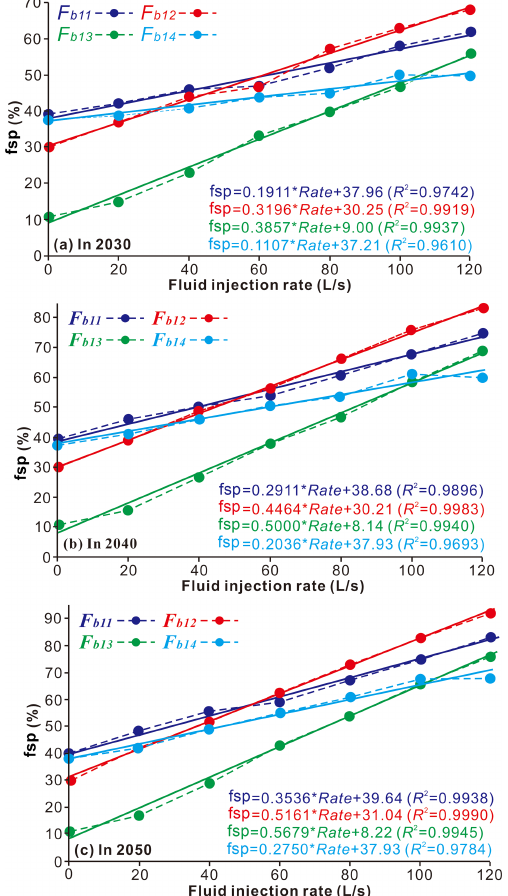
Figure 13. The effect of the injection rate on probabilistic fault slip potential on the mapped faults F b11 , F b12 , F b12 , and F b14 , within a range of ∼ 6–10km away from the MTY EGS